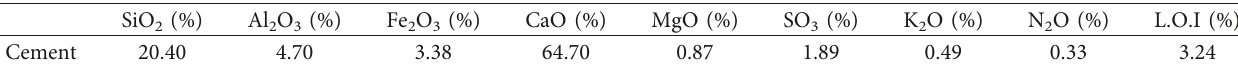
Table 3: Chemical composition of PI 52.5 Portland cement.